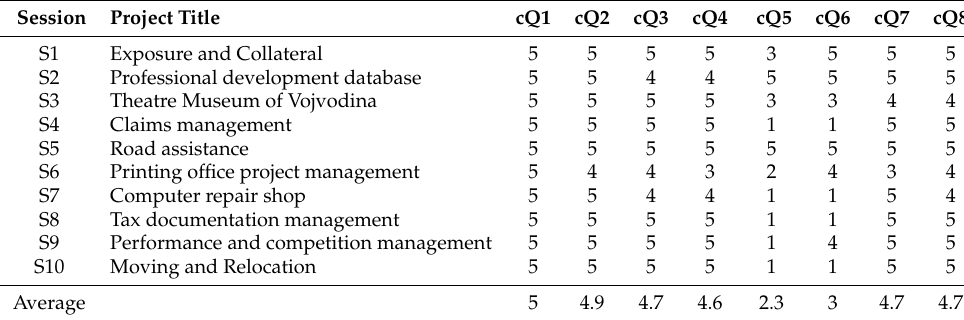
Table 7. Developed application prototype evaluation